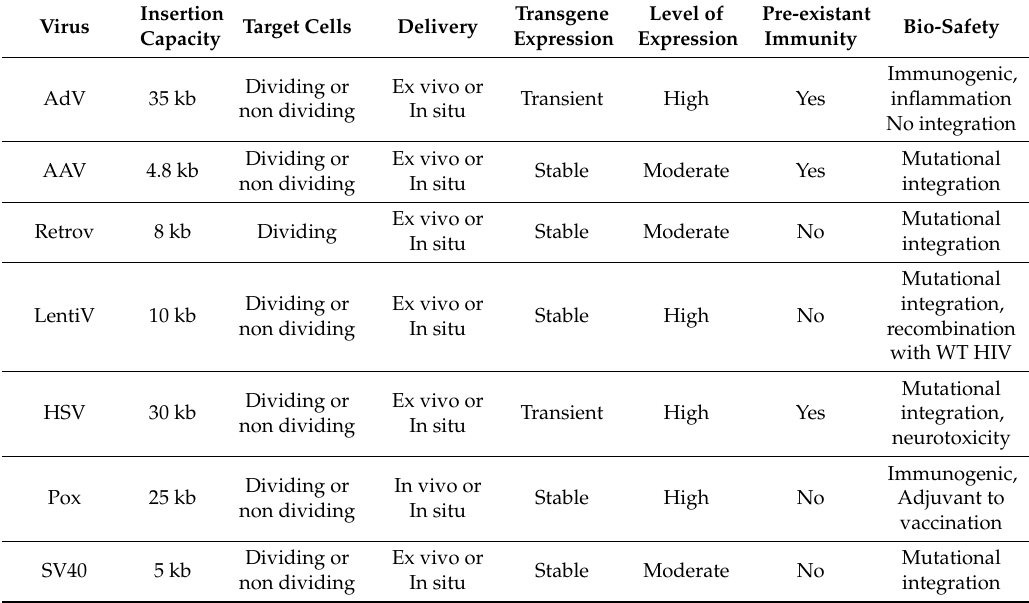
Table 1. Main viral vector and their characteristics used in pre-clinical and clinical strategies of gene therapy for pancreatic